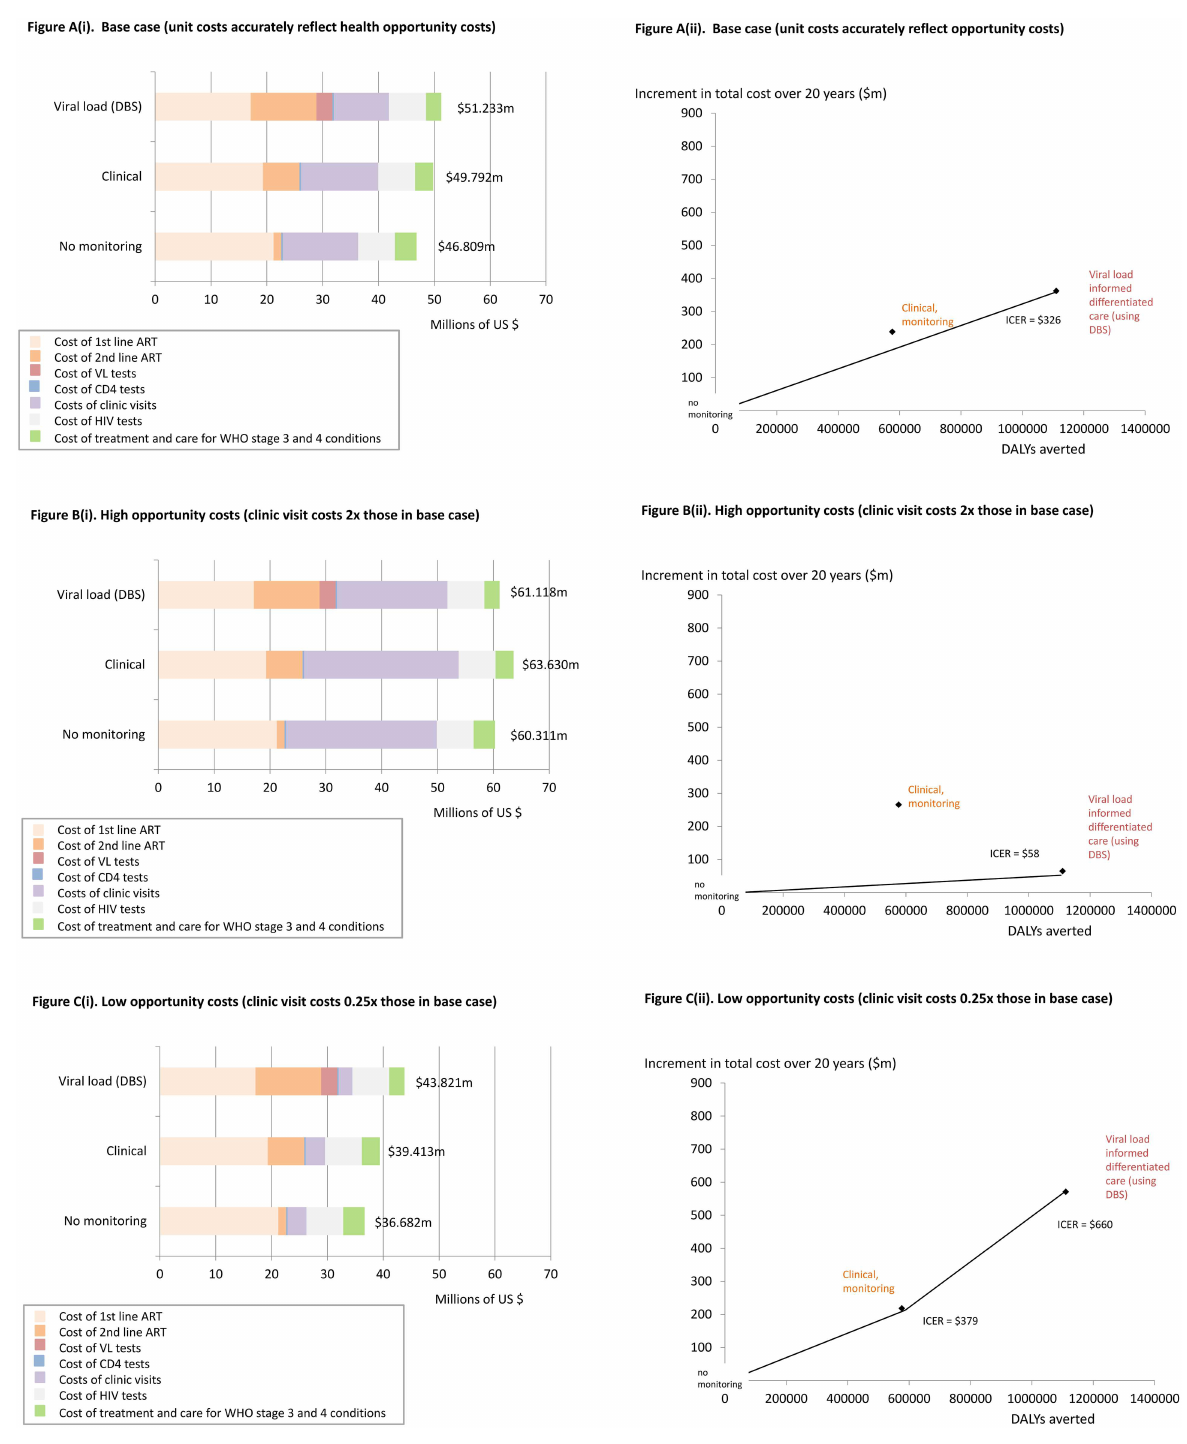
Fig 1. Cost-effectiveness of viral-load informed differentiated care using dried blood spots (VLM-DBS) under alternative assumptions about the opportunity costs of clinic capacity use. Disaggregated costs adjusted for opportunity costs of resources are provided in the left side figures and associated cost-effectiveness planes, showing the incremental cost-per-DALY-averted (ICER) with VLM-DBS, are provided on the right. Under the base case analysis in (A), a cost-effectiveness threshold of $500 is applied to clinic visits and all other costs. The ICER of VLM-DBS is $326. Under the high opportunity scenario (B), a lower cost-effectiveness threshold of $250 is applied to clinic visit costs only and the ICER of VLM-DBS is $58. Under the low opportunity costs scenario (C), a higher cost-effectiveness threshold of $2,000 is applied to clinic visit costs only and the ICER of VLM-DBS is